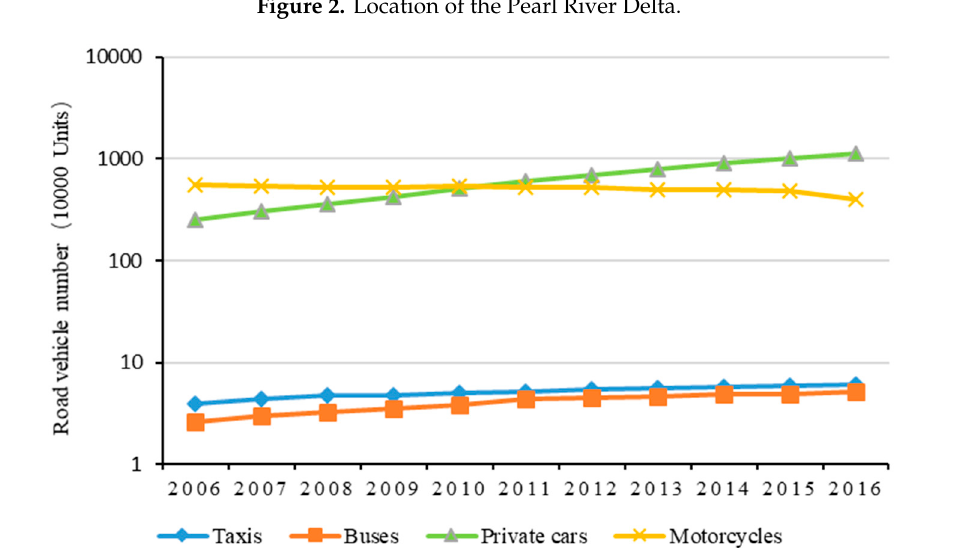
Figure 3. Road vehicle numbers in the Pearl River Delta, 2006-2016.